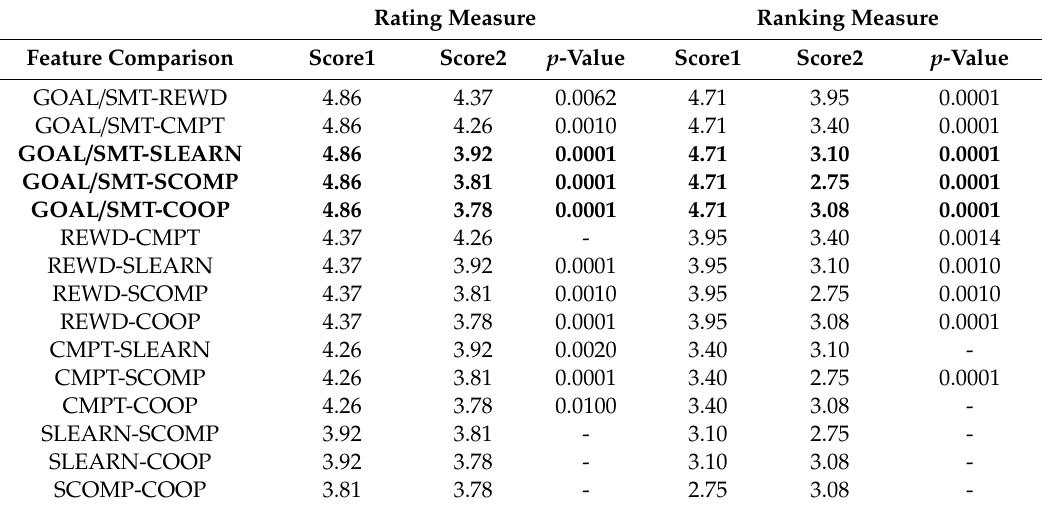
Table 4. Posthoc pairwise comparisons of persuasive features for the overall population sample. “-” means there is no significant di ff erence between each pair of features; bold values indicate the result of pairwise comparison is in the same direction regardless of measure and culture; REWD = Reward, GOAL / SMT = Goal-Setting / Self-Monitoring, CMPT = Competition, SCOMP = Social Comparison, SLEARN = Social Learning, COOP = Cooperation.